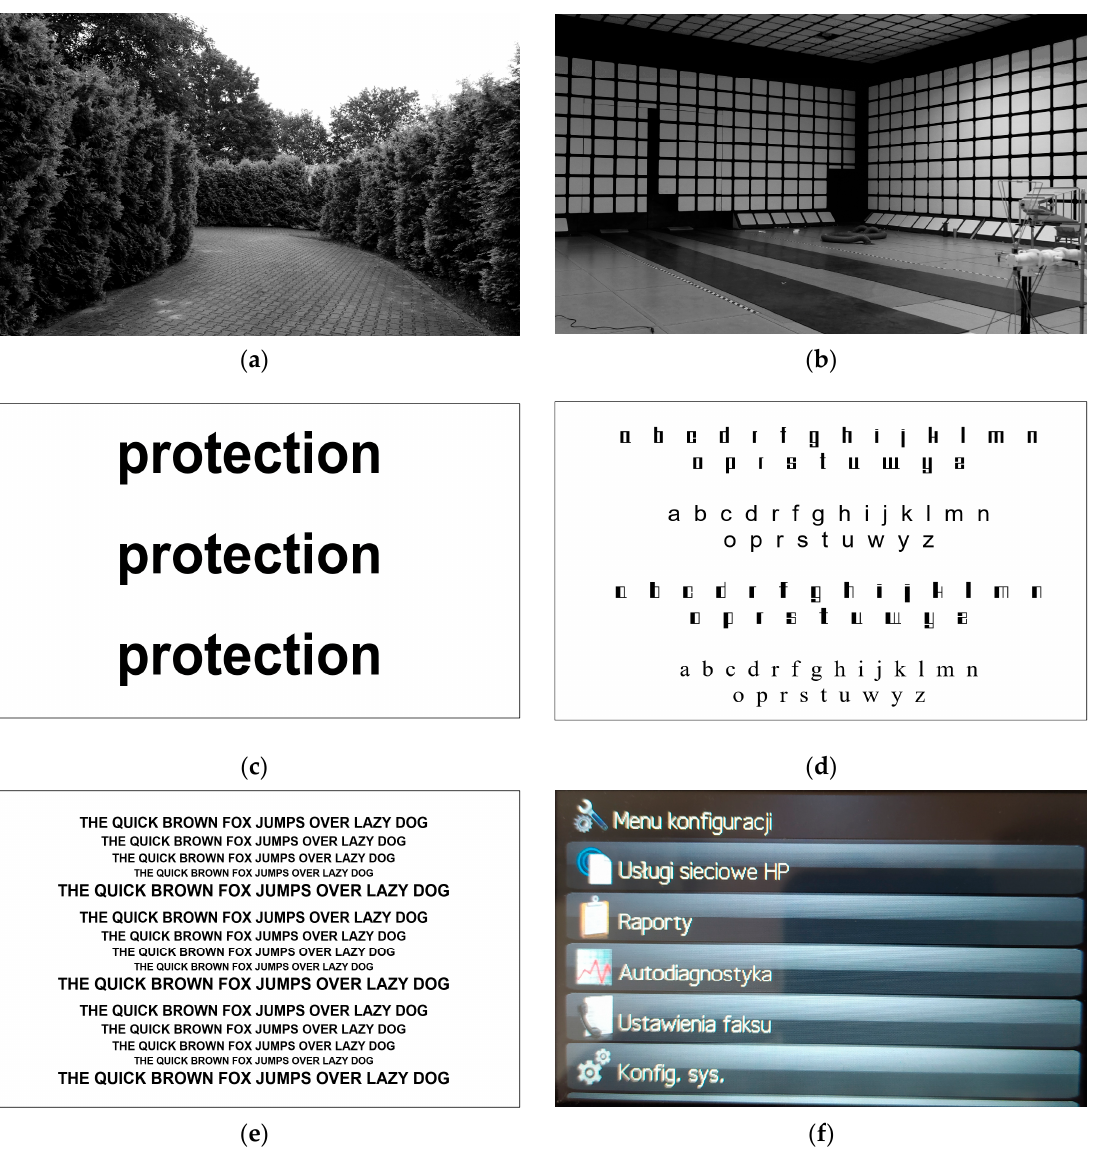
Figure 7. Images displayed on a computer monitor ( a – c , e , f ) or multifunction device display ( d ), which are the source of revealing emissions: ( a ) a photo showing the road along the bushes, ( b ) a photo of the inside of an anechoic chamber, ( c ) three words “protection”, letter size 36, Arial font, ( d ) letter signs written with four fonts Safe Symmetric, Arial, Safe Asymmetric, Times New Roman, ( e ) a sentence written in Arial font of various sizes of letters, ( f ) display screen (Configuration menu) of the multifunction device.